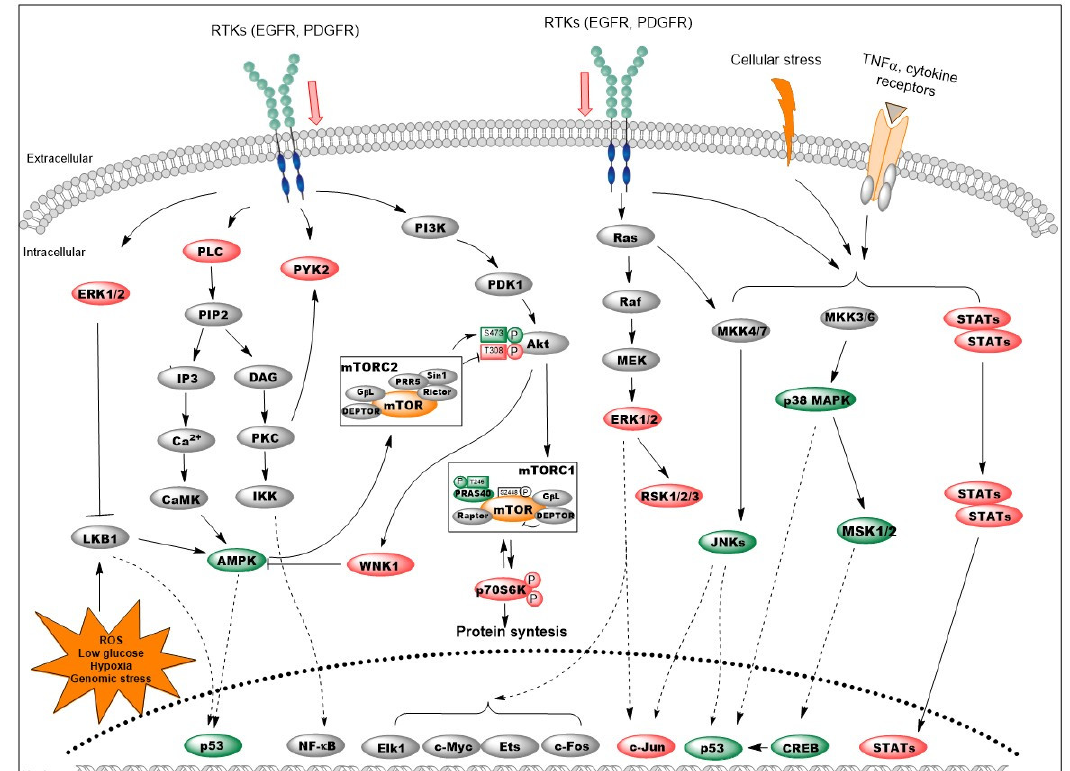
Figure 7. Changes in the signaling network of colorectal cancer (CRC) liver metastases upon decorin delivery. Liver-specific transfection with the DCN gene inhibited several RTKs with a concomitant decrease in the activity of the MAPK/ERK and Akt/mTOR/p70S6K pathways. Increased AMPK (possibly via LKB1) and p38/MSK/CREB signaling resulted in elevated phospho-p53 levels; stabilization of this key tumor suppressor may result in a cell cycle blockade. Inhibition of STATs and c-Jun proteins also contributes to the antitumor action of decorin. Color code: red: decreased; green: increased; orange: no change; grey: not examined. Additional details are included in the text.